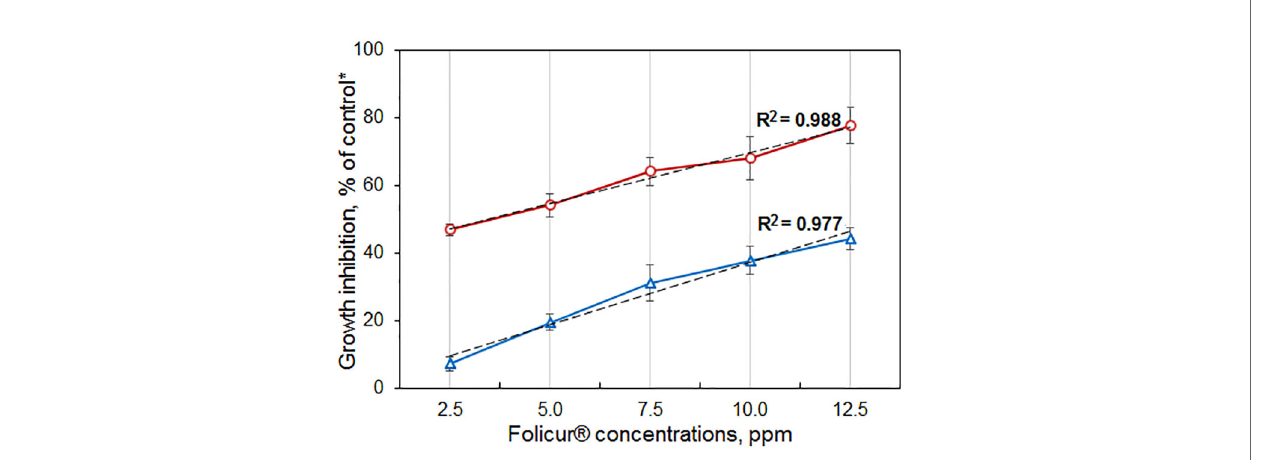
FIGURE 3 | Dependence of P. nodorum m8-4 growth inhibition on concentrations of Folicur ® incorporated into potato dextrose agar (PDA). *Colonies grown on Folicur ® -free PDA served as control. Dotted lines indicate lines corresponding to linear function. R 2 values and Y-bars show con fi dence coef fi cients and SD, respectively. Red and blue lines are percent growth inhibition after 7 and 21 days,